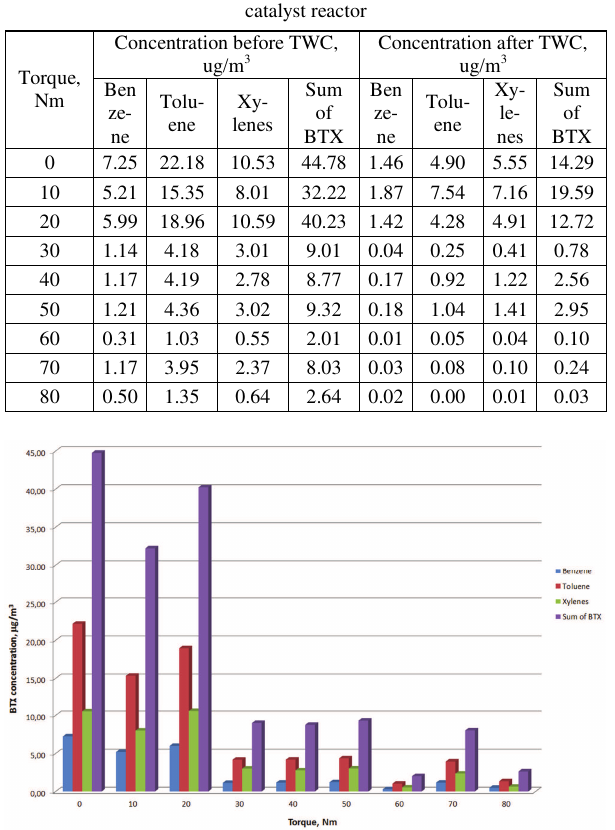
Fig. 4. Concentration of BTX (in m g/m 3 ) before catalyst reactor depending on the torque value